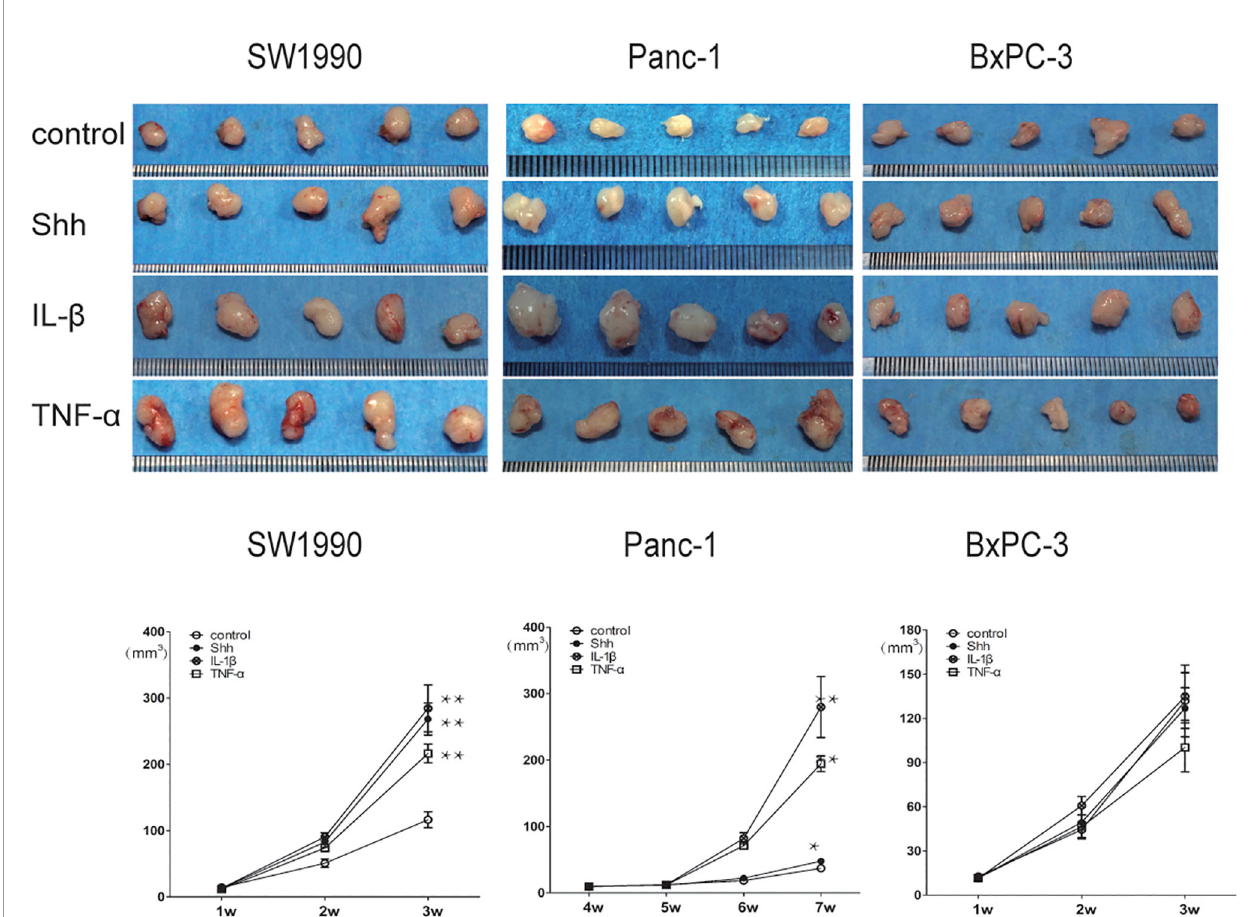
FIGURE 7 | Tumor growth was signi fi cantly promoted by IL-1 b , TNF- a , and Shh in mice inoculate d with MT-KRAS cells compared with those inoculated with WT-KRAS cells; *p < 0.05; **p <